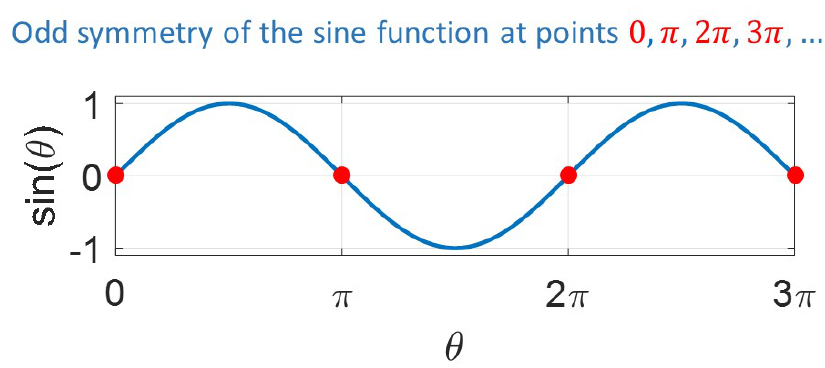
Figure 4. Odd symmetry of the sine function at k π ( k = 0,1,2, . . .